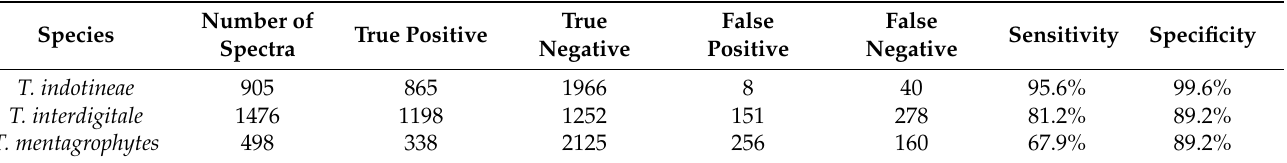
Table 2. Number of spectra, sensitivity, specificity, and number of true positive, true negative, false positive, and false negative identifications for the three